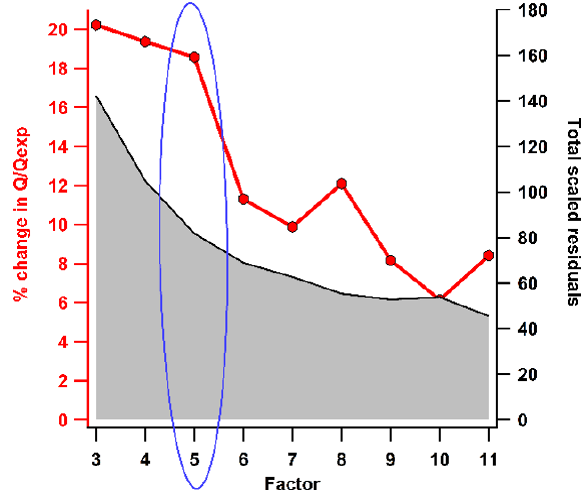
Figure 2. The Q/Q exp plot (percentage change) and total summed scaled residuals for each factor